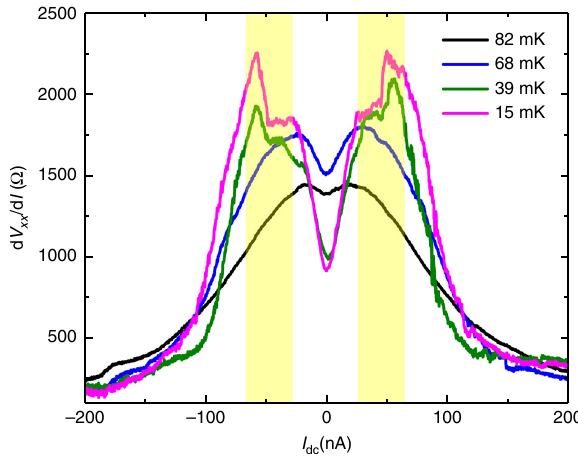
Fig. 3 Differential resistance vs. DC current in Sample A. The DC current was applied along the hard axis. A 4 nA AC excitation current was also applied to probe R xx . The yellow highlighted region indicates where we observe a plateau and then sharp increase in the differential resistance at low temperatures reminiscent of